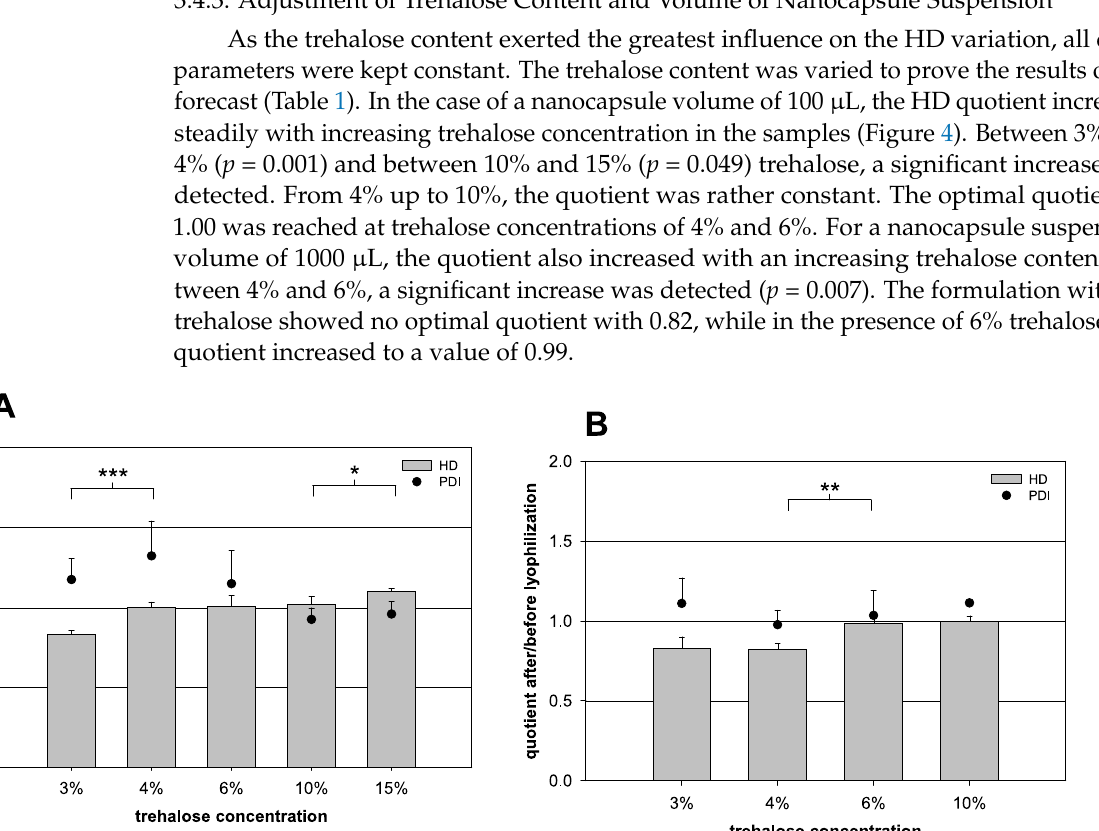
Figure 5. Influence of the lyophilization on the quotient of the hydrodynamic diameter (HD, bars) and the quotient of the polydispersity index (PDI, dots) before and after lyophilization, respec- tively. Different volumes of nanocapsule suspension were combined with a fixed trehalose content of 6% ( w / v ) (statistical test: one-way ANOVA; no significance between the compared groups re- garding the HD quotient; p = 0.326; mean ± SD; n = 3). 3.5. Long-Term Storage of the Lyophilized Product The long-term storage capability of the lyophilizates was analyzed by observing the HD and PDI quotients over 66 weeks of storage followed by sample reconstitution (Figure 6). After about one week, the HD still presented an optimal quotient of 1.00. Some fluctu- ations could be detected starting in the third week. However, even after 66 weeks, no sig- nificant increase occurred and an acceptable HD quotient of 0.97 was reached ( p = 0.146). The analysis of the PDI quotient was once again difficult, as it differed over the storage time.